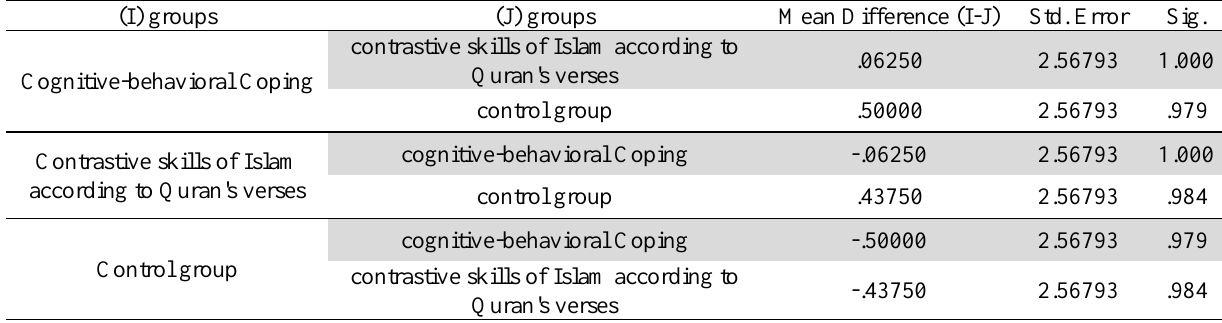
The summary of anxiety in pre-test stage